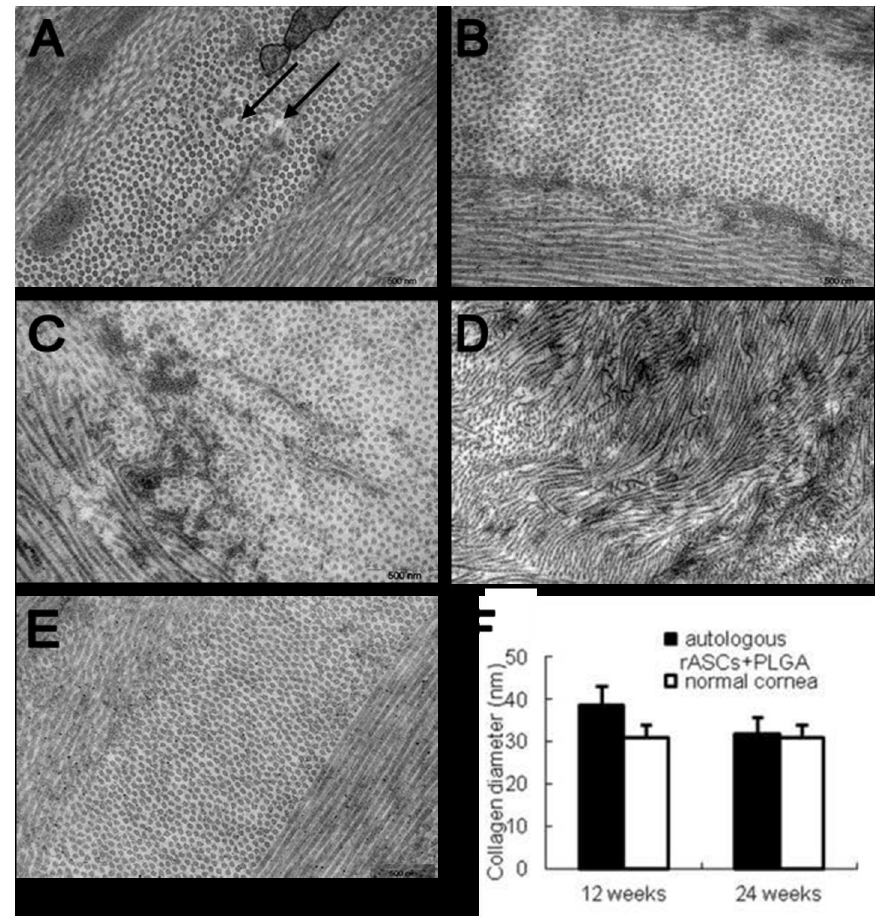
Figure 5. Distribution and diameter of collagen fibrils in different groups observed by transmission electron micrography. A, B: the rASCs+PLGA group autologous; C: PLGA group; D: Only defect group; A: 12 weeks post-implantation; B- D: 24 weeks post-implantation. (E) Distribution and diameter of collagen fibrils in normal cornea. Electron microscopic examination showed larger interfibrillar interval existed in the neoformative stromal matrix (arrow in Figure 5A) at 12 weeks, while normal lamellae containing regularly spaced fibrils formed at 24 weeks. Fibril diameter analysis showed neoformative stroma regained the identical diameter distribution of collagen fibrils to those of normal rabbit corneas in auto-rASCs group at 24 weeks